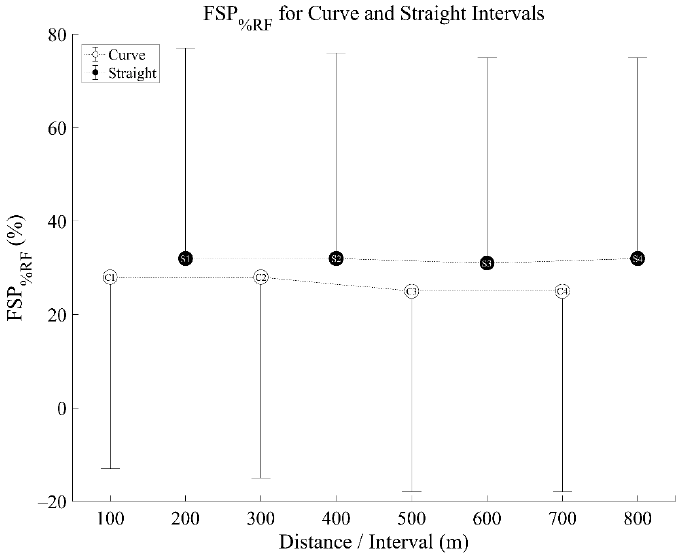
Figure 5. Percentage Rearfoot Strike Pattern (FSP %RF ) for curve and straight intervals—mean (cir- cles) ± standard deviation bar (vertical lines—shown in one direction only). C1 signifies ‘Curve 1 ′ , S1 signifies ‘Straight 1’. There were no significant differences between distances/intervals.